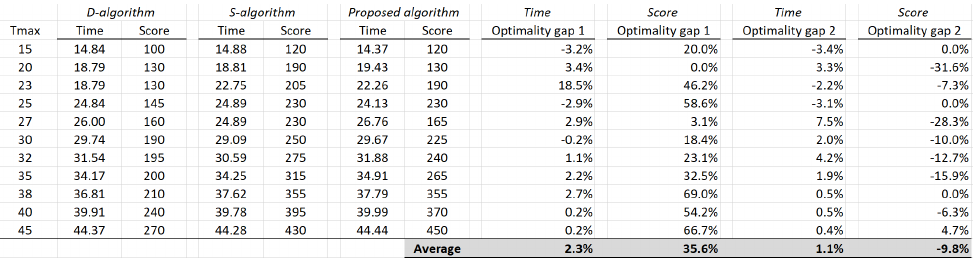
Figure 8. Algorithms comparison using data set of problem 2.